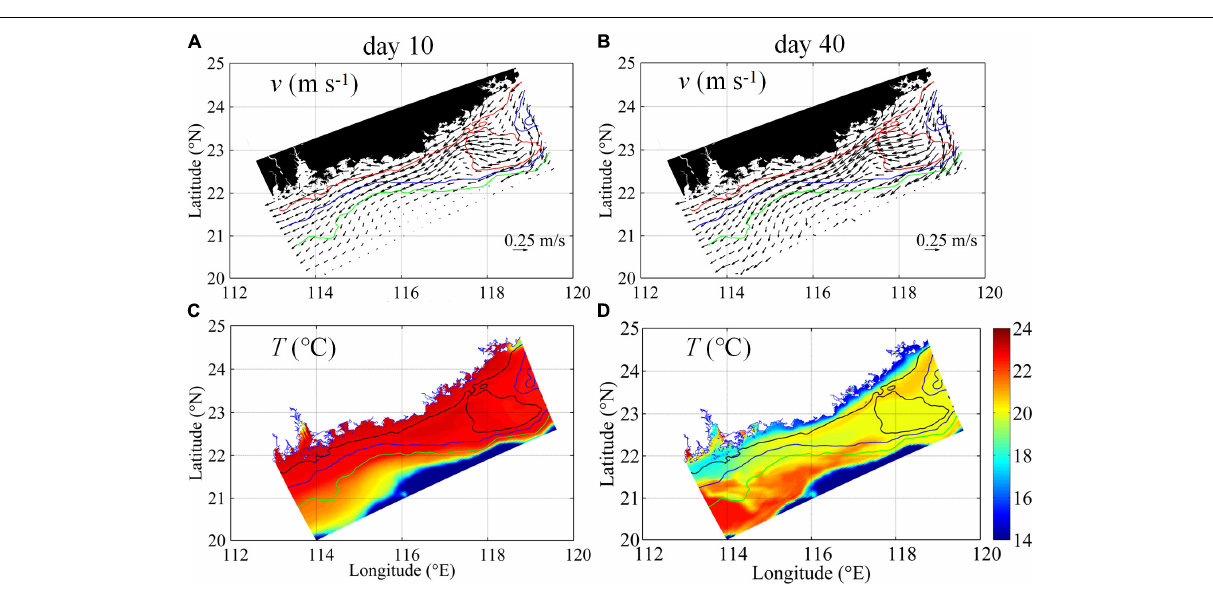
Frontiers in Marine Science |